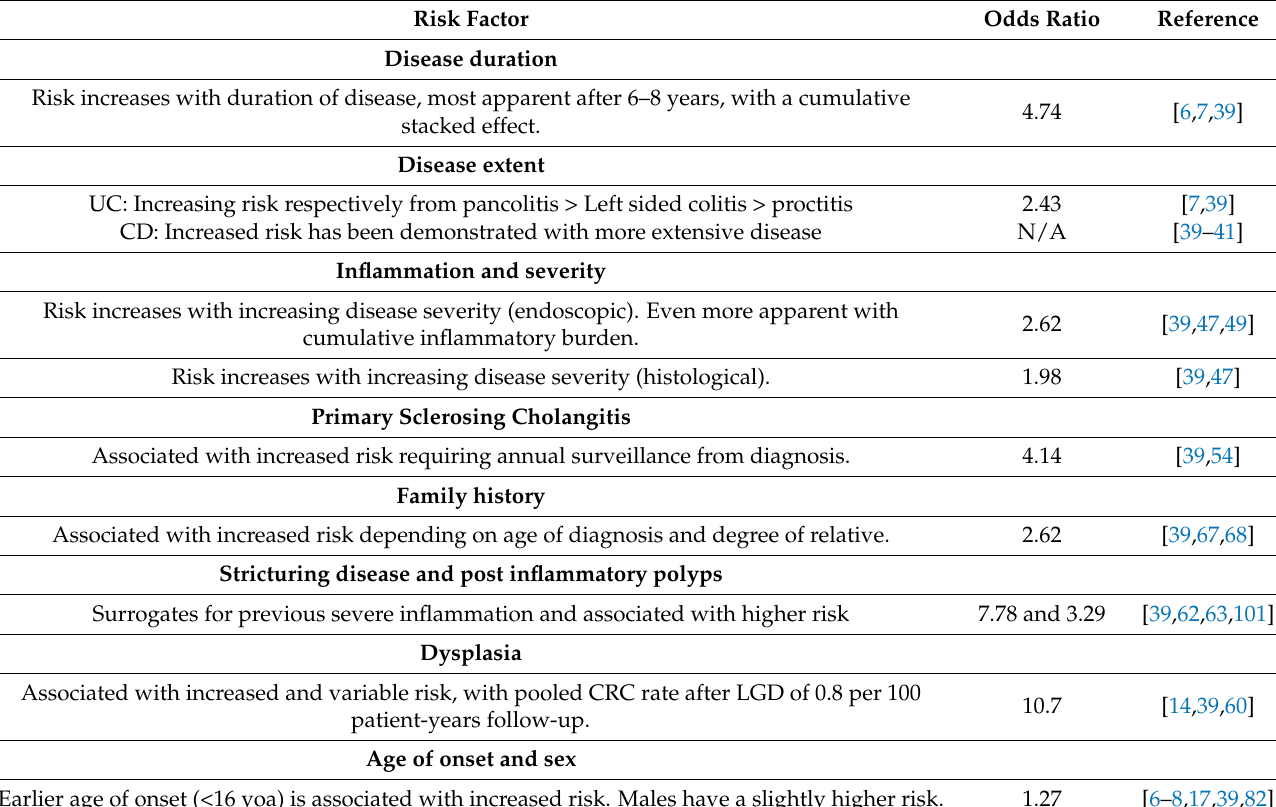
Table 1. Summary of Clinical risk factors associated with increased risk of CRC in patients with UC and CD. Risk Factor Odds Ratio Reference Disease